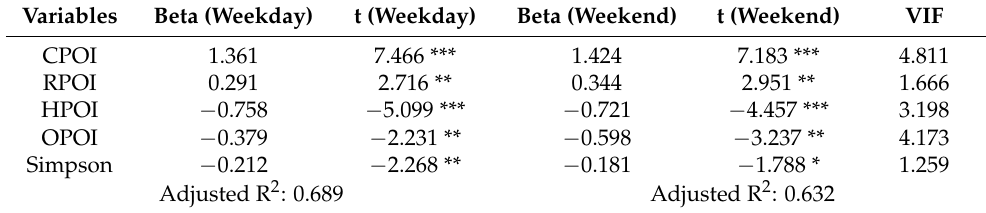
Table 5. The OLS regression